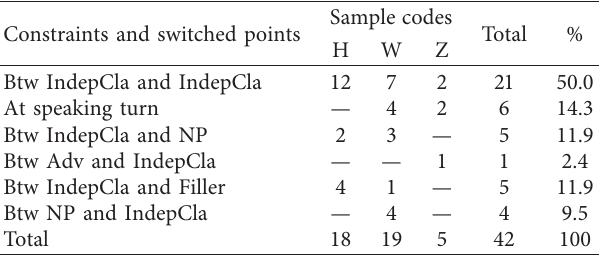
Table 4: The constraints and switched points of English-Indo- nesian code-switching. Constraints and switched